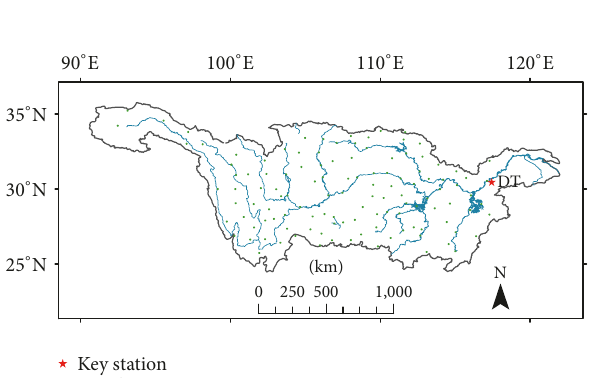
Figure 6: Results of 𝑅/𝑆 analysis.